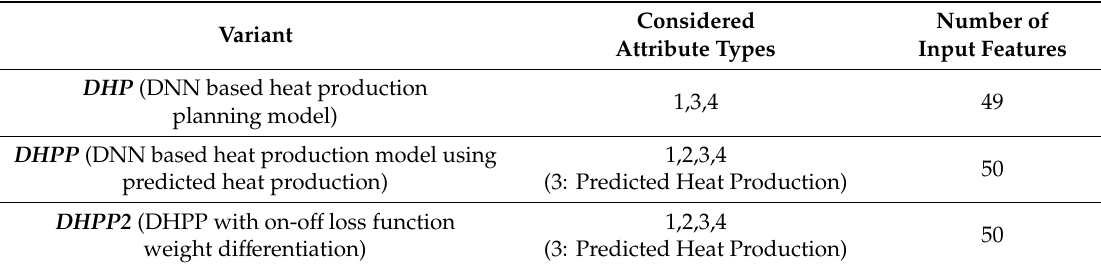
Table 4. Attributes of DNN Model Variants.